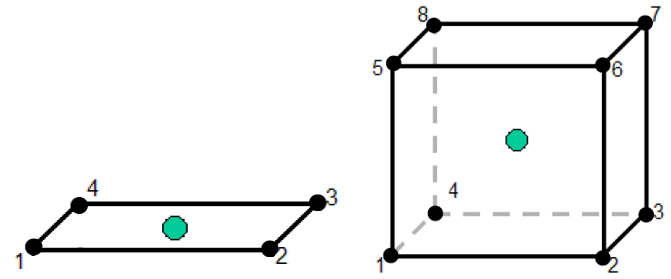
Figure 9. Two-dimensional and three-dimensional elements for meshing. Figure 9. Two ‐ dimensional and three ‐ dimensional elements for meshing. Figure 9. Two ‐ dimensional and three ‐ dimensional elements for meshing.